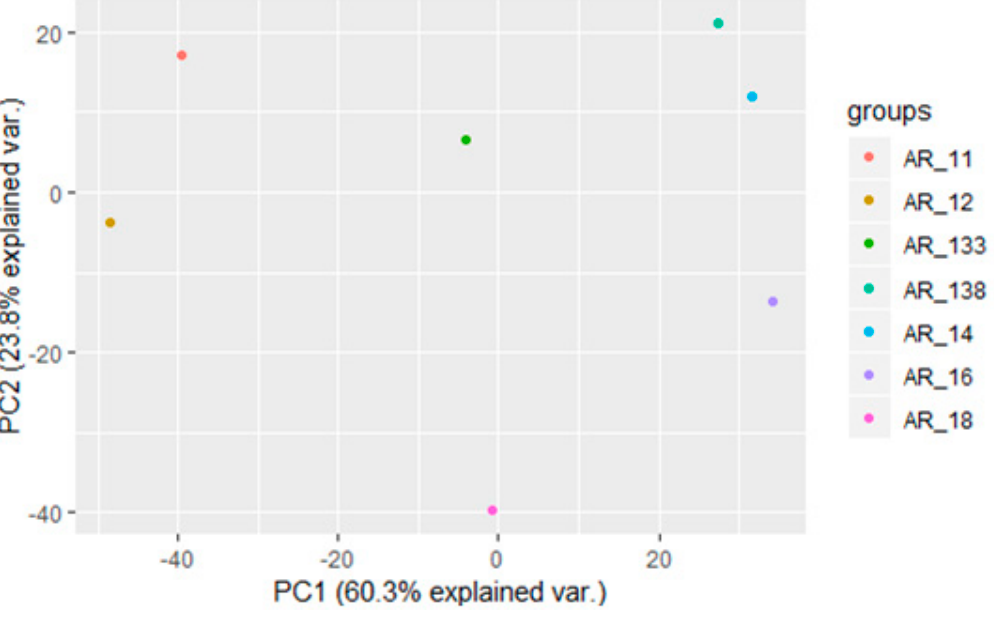
Figure 4. PCA of mean values for the 1900 absorbance values of FT-NIR spectra for the seven maturity levels of “Autumn Royal” grape: 11° (AR11), 12° (AR12), 13.3° (AR133), 13.8° (AR138), 14° (AR14), 16° (AR16), and 18° (AR18) Brix.